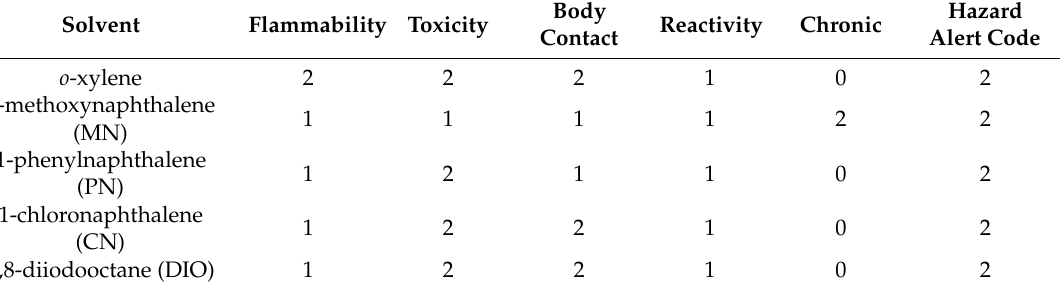
Table 2. Hazard identification and classification of the solvents